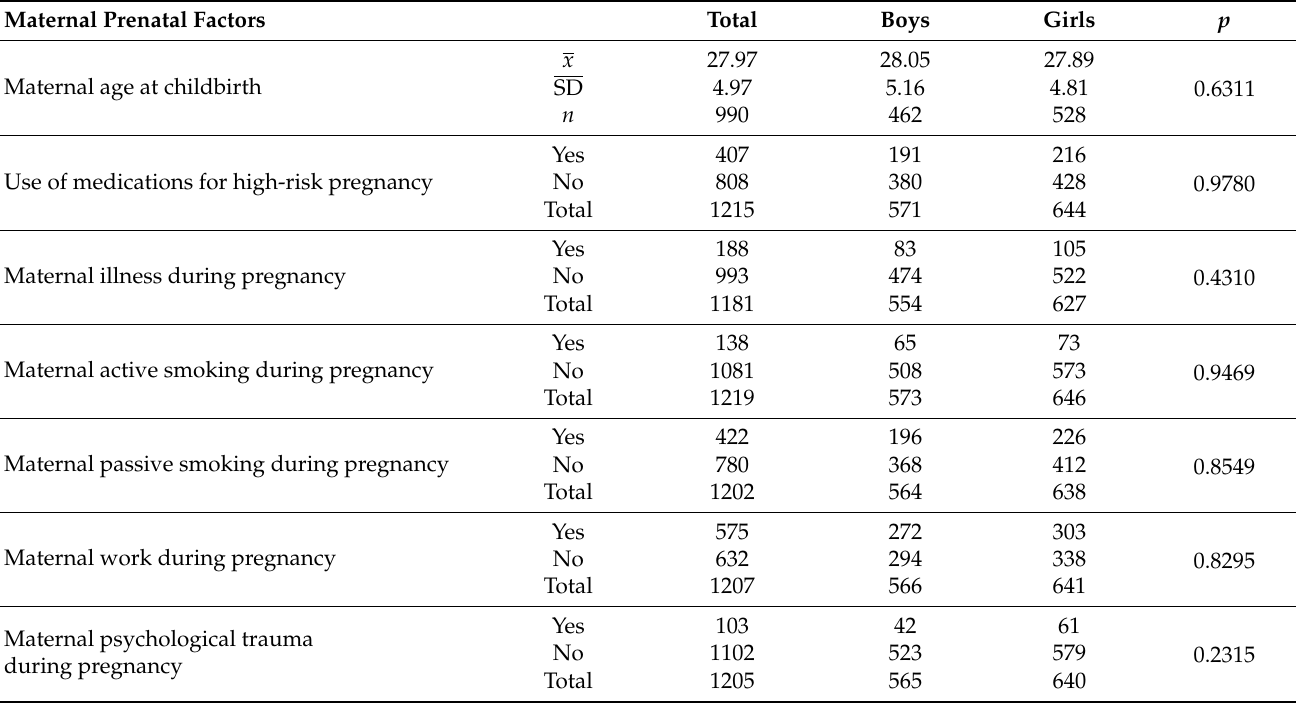
Table 3. Maternal prenatal factors by child